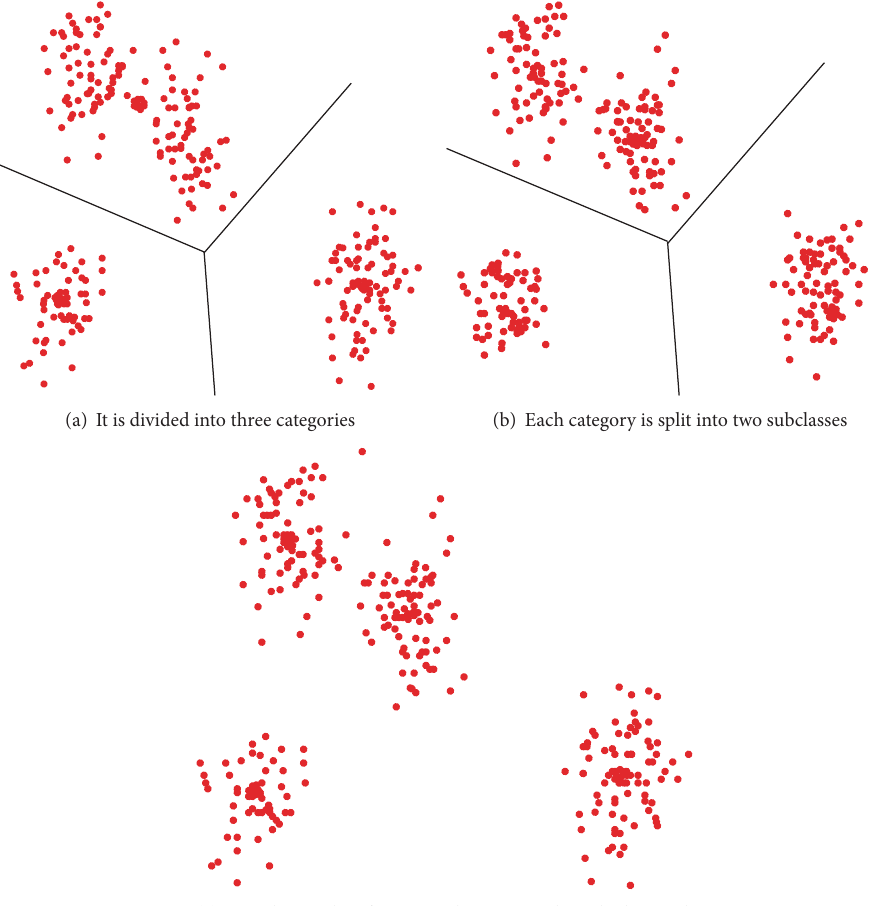
Figure 2: Schematic diagram of AKM